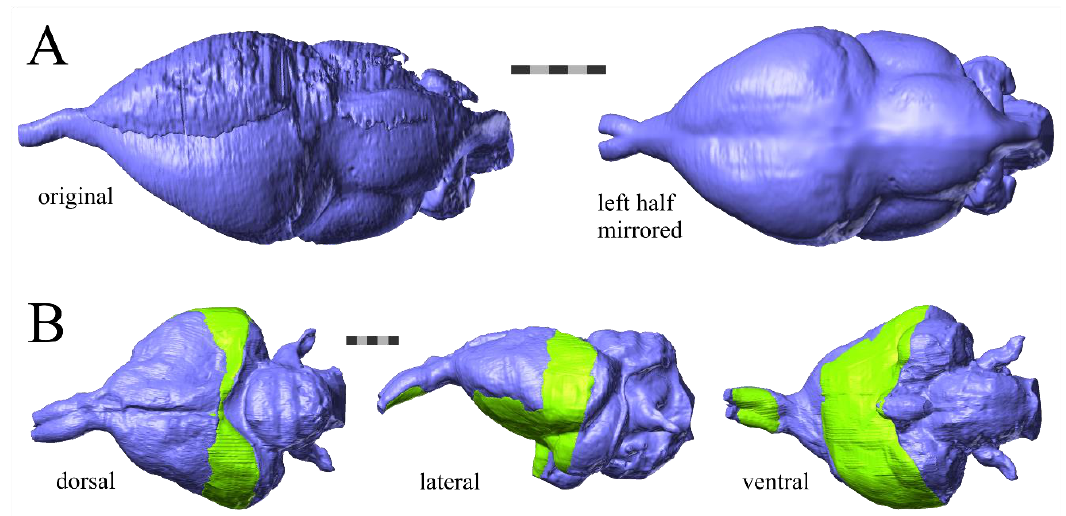
Figure 3. Examples of varying degrees of artifactual damage and deformation represented in a subsample of fossil endocasts. ( A ) The original endocast of Archaeopteryx lithographica (NHMUK PAL PV OR 37001) (left) compared to the endocast that was generated by mirroring the left half of the endocast on the midline (right); both endocasts are in dorsal view. ( B ) The endocast of Lithornis plebius (USNM PAL 336534) in three views with preserved portions of the endocast shown in blue and the interpolated portions created to span the gap in green. Scale bars = 5 mm.